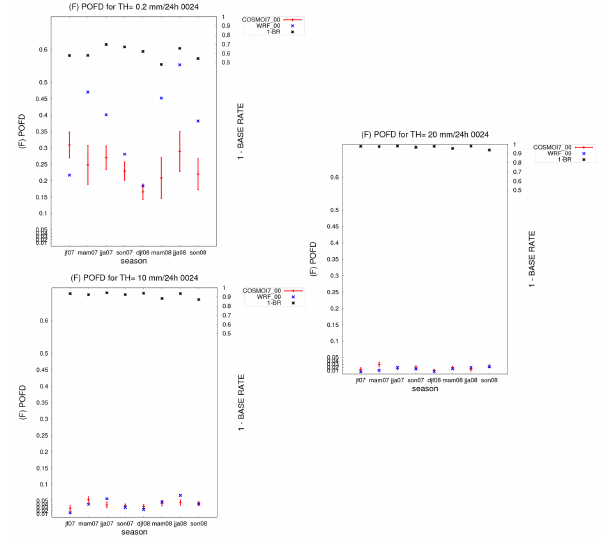
Fig. 8. Seasonal trend: POFD vs. increasing threshold (0.2mm24h − 1 , 10mm24h − 1 , 20mm24h − 1 ) for the first day of forecast. The dashed red lines and the blue daggers represent COSMO-I7 and WRF, respectively. The Base Rate (stars) is plotted for each threshold.